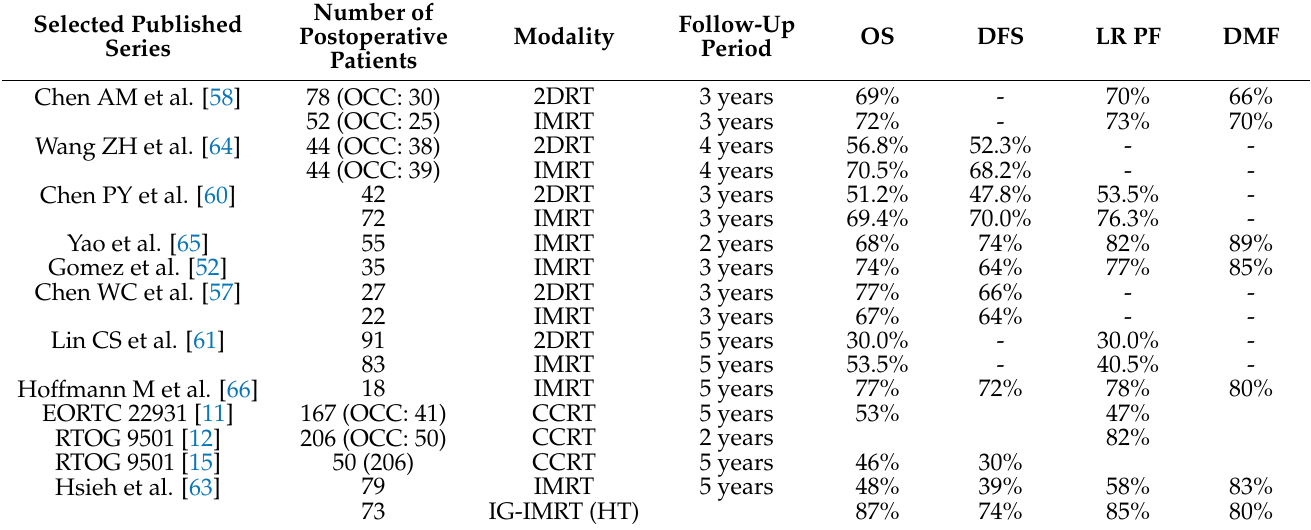
Table 2. Treatment outcomes with different radiotherapy techniques and forms of image guidance. Selected Published